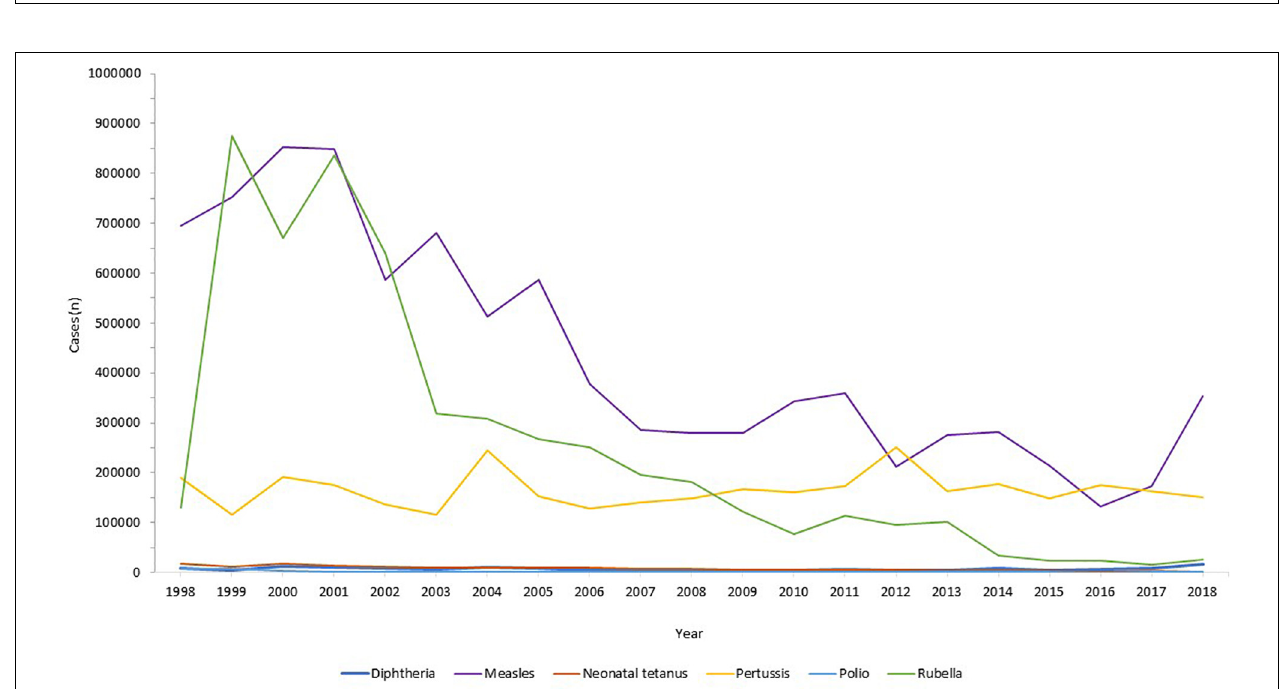
FIGURE 2 | Vaccine uptake across different regions defined by economic status by the World Bank into high- (solid line), middle- (dashed line), and low-income countries (dotted line) for the past 20 years. Data from the World Health Organization and UNICEF dataset “Coverage Estimates Series” (World Health Organization [WHO] and United Nations Children’s Fund [UNICEF], 2019).